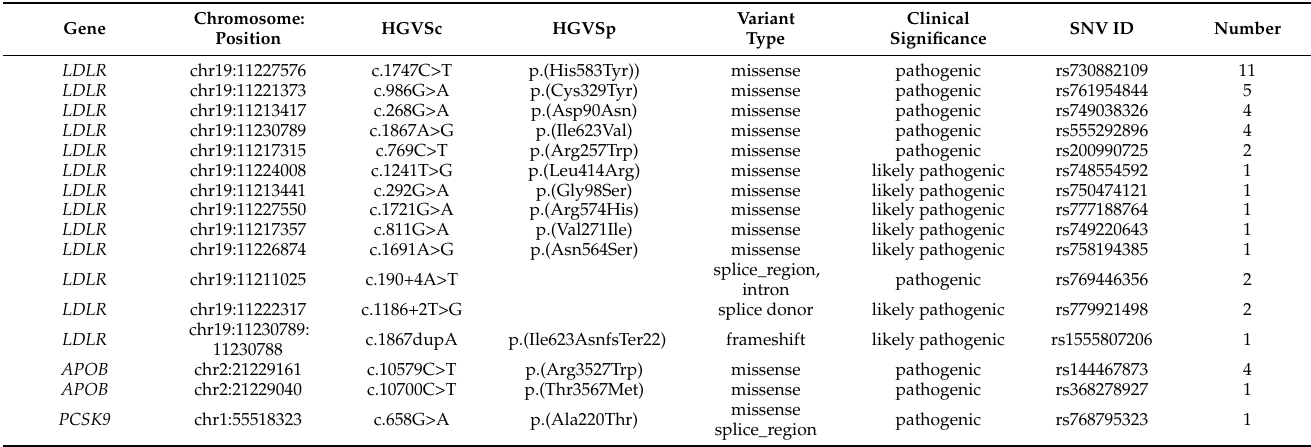
Table 2. Identified FH pathogenic gene loci in the study cohort.